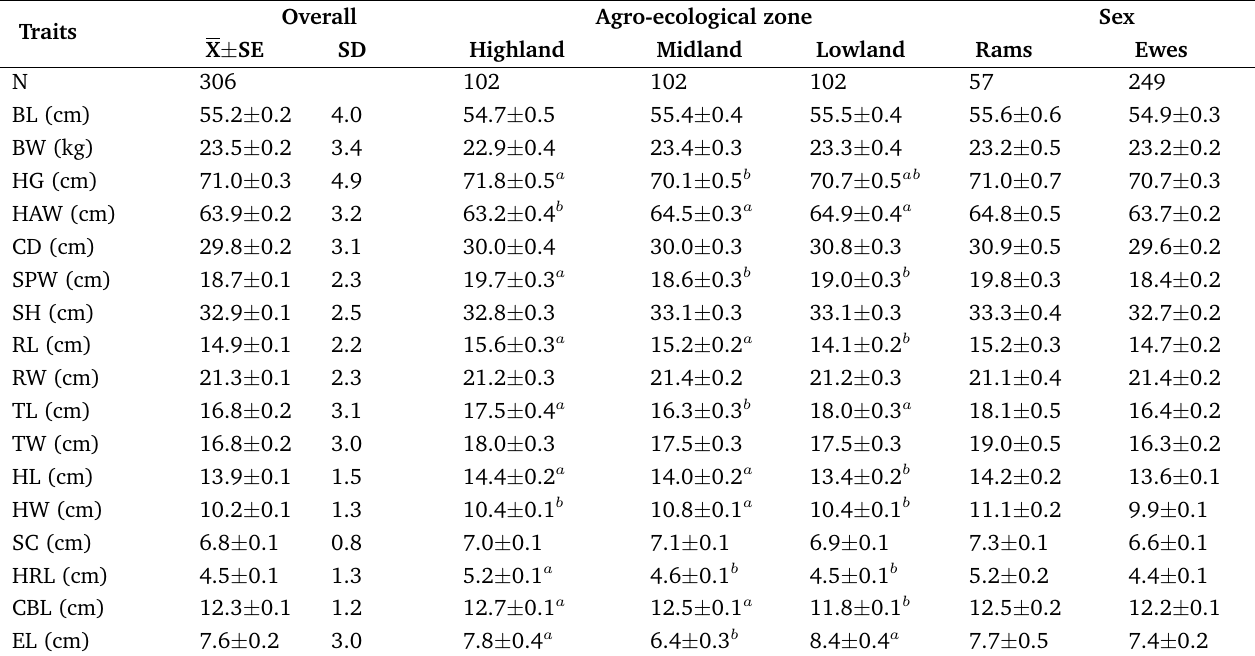
Table 3. Overall mean (X), standard error (SE), standard deviation (SD) and pairwise mean comparison (least square means and standard errors) for the effect of agro-ecological zone and sex. Means within a column bearing different superscripts are significantly different; a is given to the highest value.